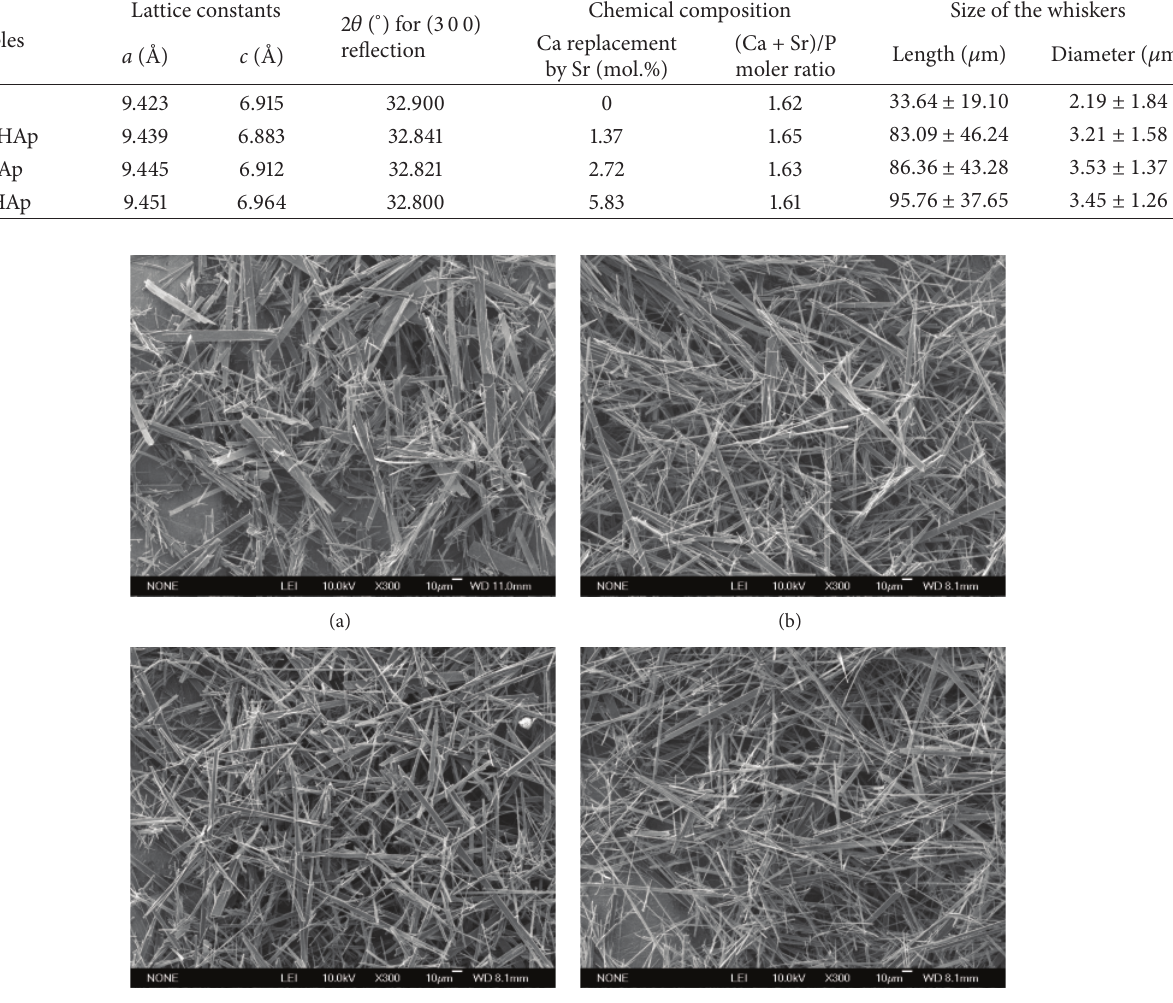
Table 1: Lattice constants, 2 𝜃 value for (3 00) diffraction, chemical composition, and size of the synthetic HAp and Sr-substituted HAp whiskers.